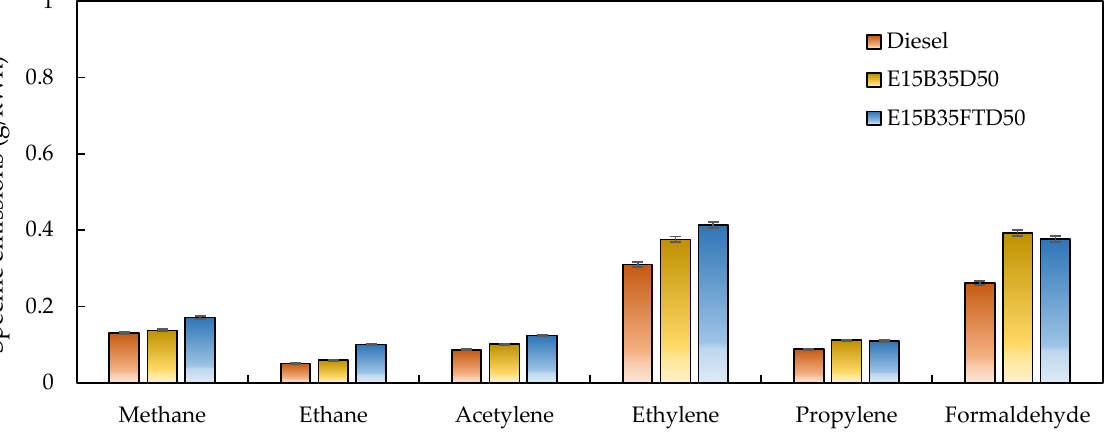
Figure 4. HC speciation for diesel, E15B35D50, and E15B35FTD50.